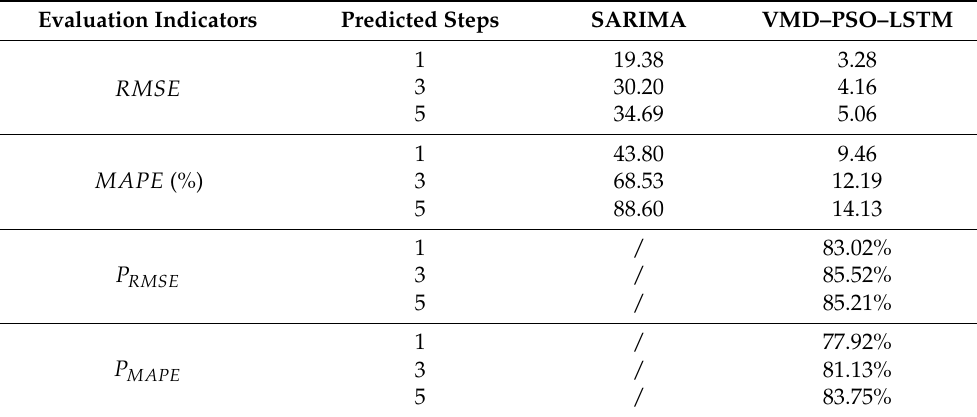
Table 7. SARIMA and VMD–PSO–LSTM model evaluation index